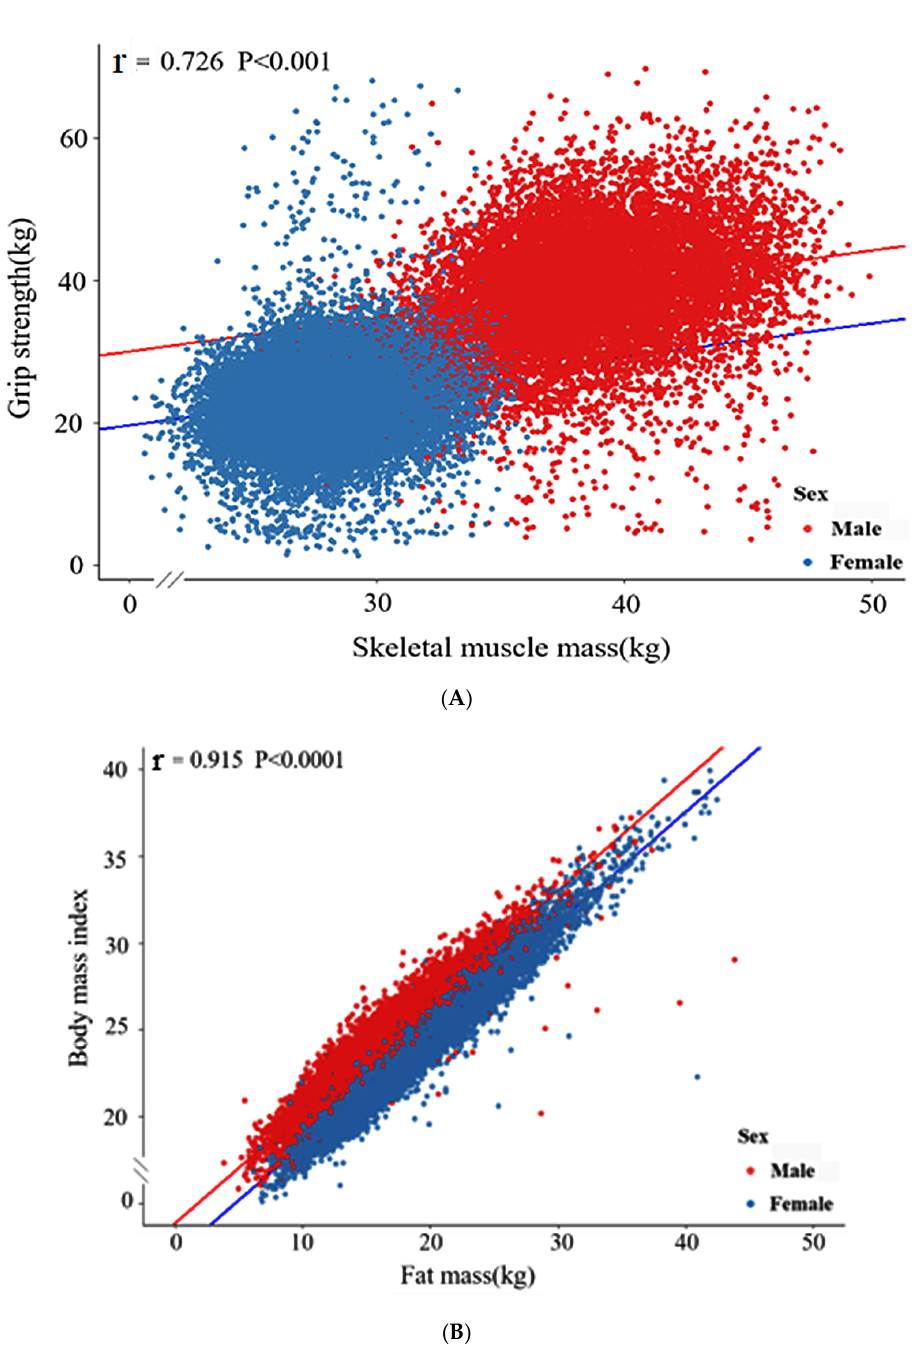
Figure 4. Linear regression analysis. ( A ) The relation between skeletal muscle mass and grip strength; ( B ) The relation between fat mass and body mass index. r, Pearson’s correlation coefficient. The p -value for the correlations.